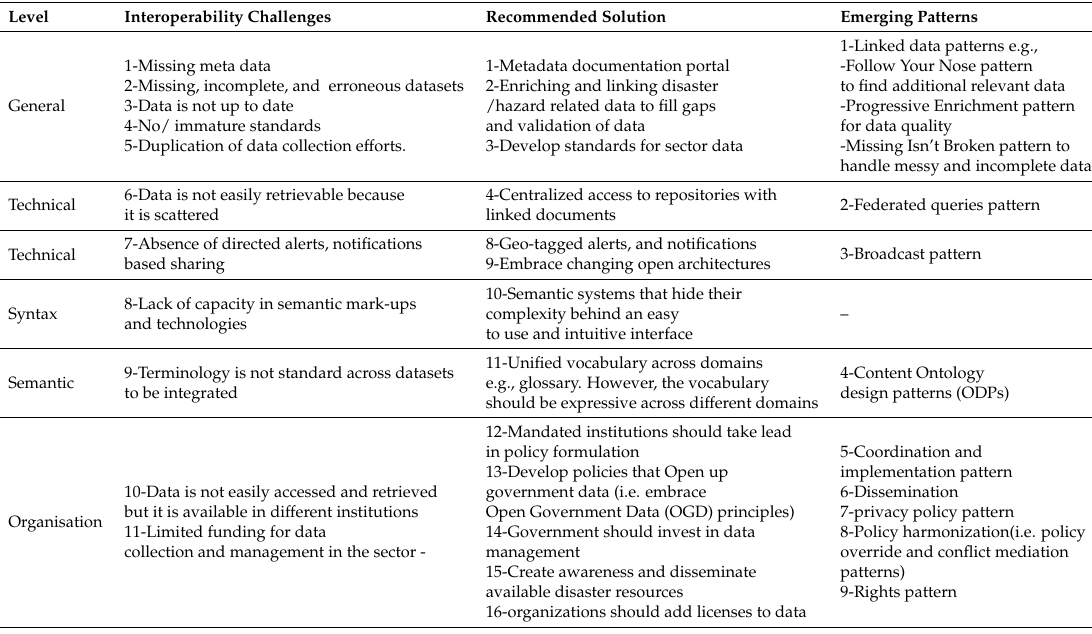
Table 4. Emerging interoperability